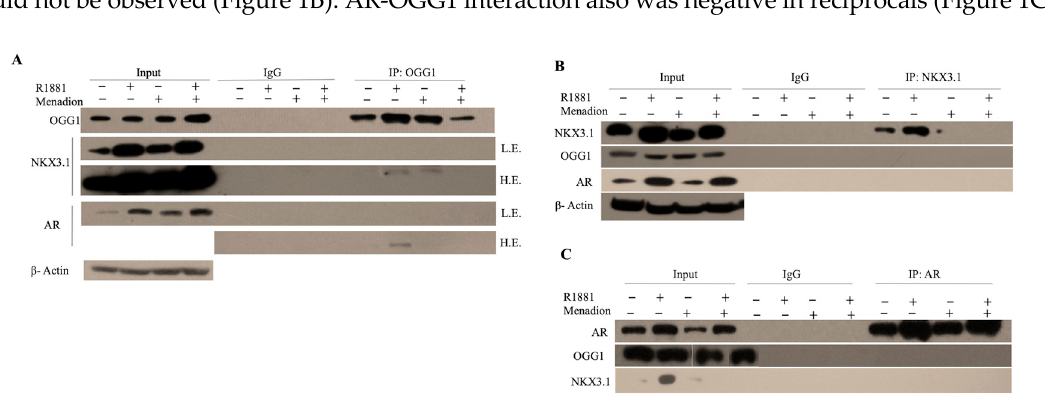
Figure 1. Physical protein-protein interaction analyses of OGG1 with NKX3.1 and AR. LNCaP cells treated with R1881 (10 nM, 24 h) and menadione (0.1 mM, 3 h) and then protein extracts were obtained. ( A ) Extracts were immunoprecipitated with a non-spesific IgG or and OGG1 antibody and then immunoblotted with NKX3.1 and AR antibody. ( B ) Extracts were immunoprecipitated with a non-spesific IgG or and NKX3.1 antibody and then immunoblotted with OGG1 and AR antibody. ( C ) Extracts were immunoprecipitated with a non-spesific IgG or and AR antibody and then immunoblotted with OGG1 and NKX3.1 antibody. L.E.: Low Exposure, H.E.: High